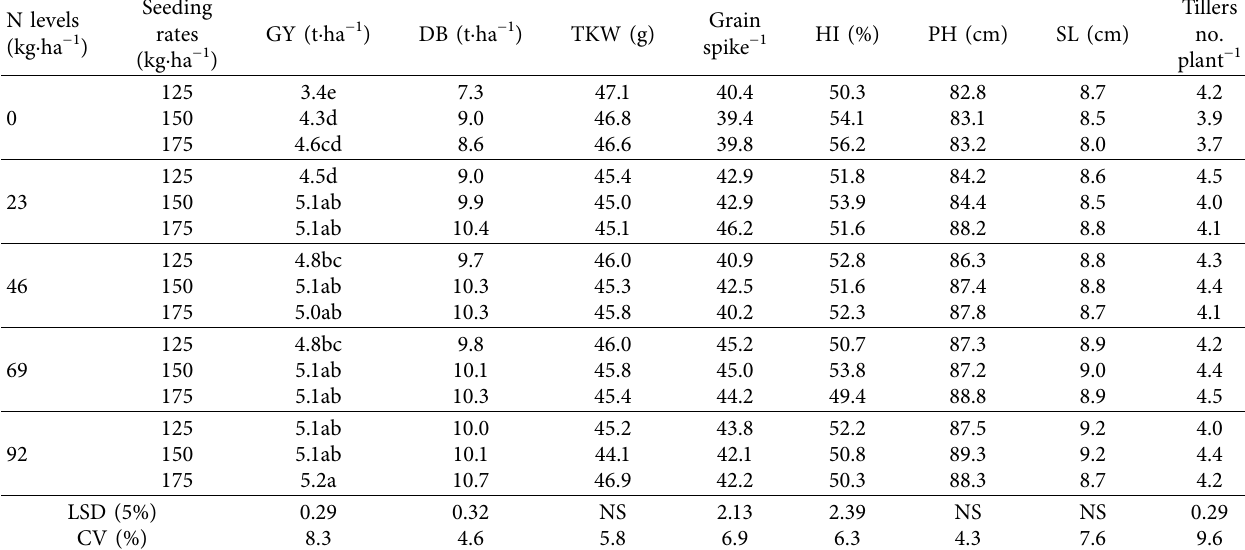
Table 4: Te overall mean efects of N and N seeding rate on grain yield, dry biomass, and other yield traits of bread wheat over locations in the 2020 in western Oromia, Ethiopia.